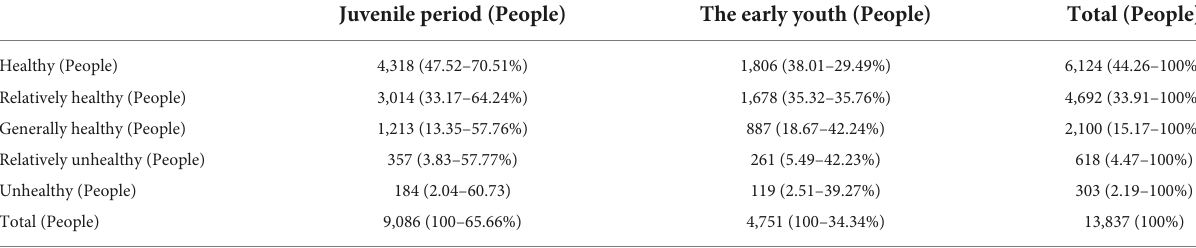
TABLE 2 Health status of adolescents in different age groups.